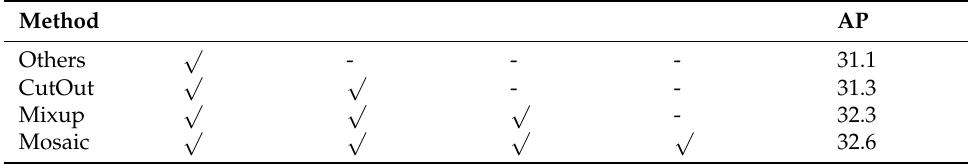
Table 4. Data augmentation ablation experiment